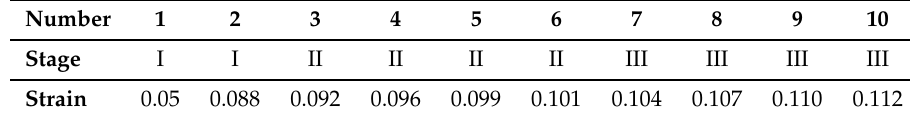
Figure 3. Deformation process of the model without void Table 2. Key points during tensile